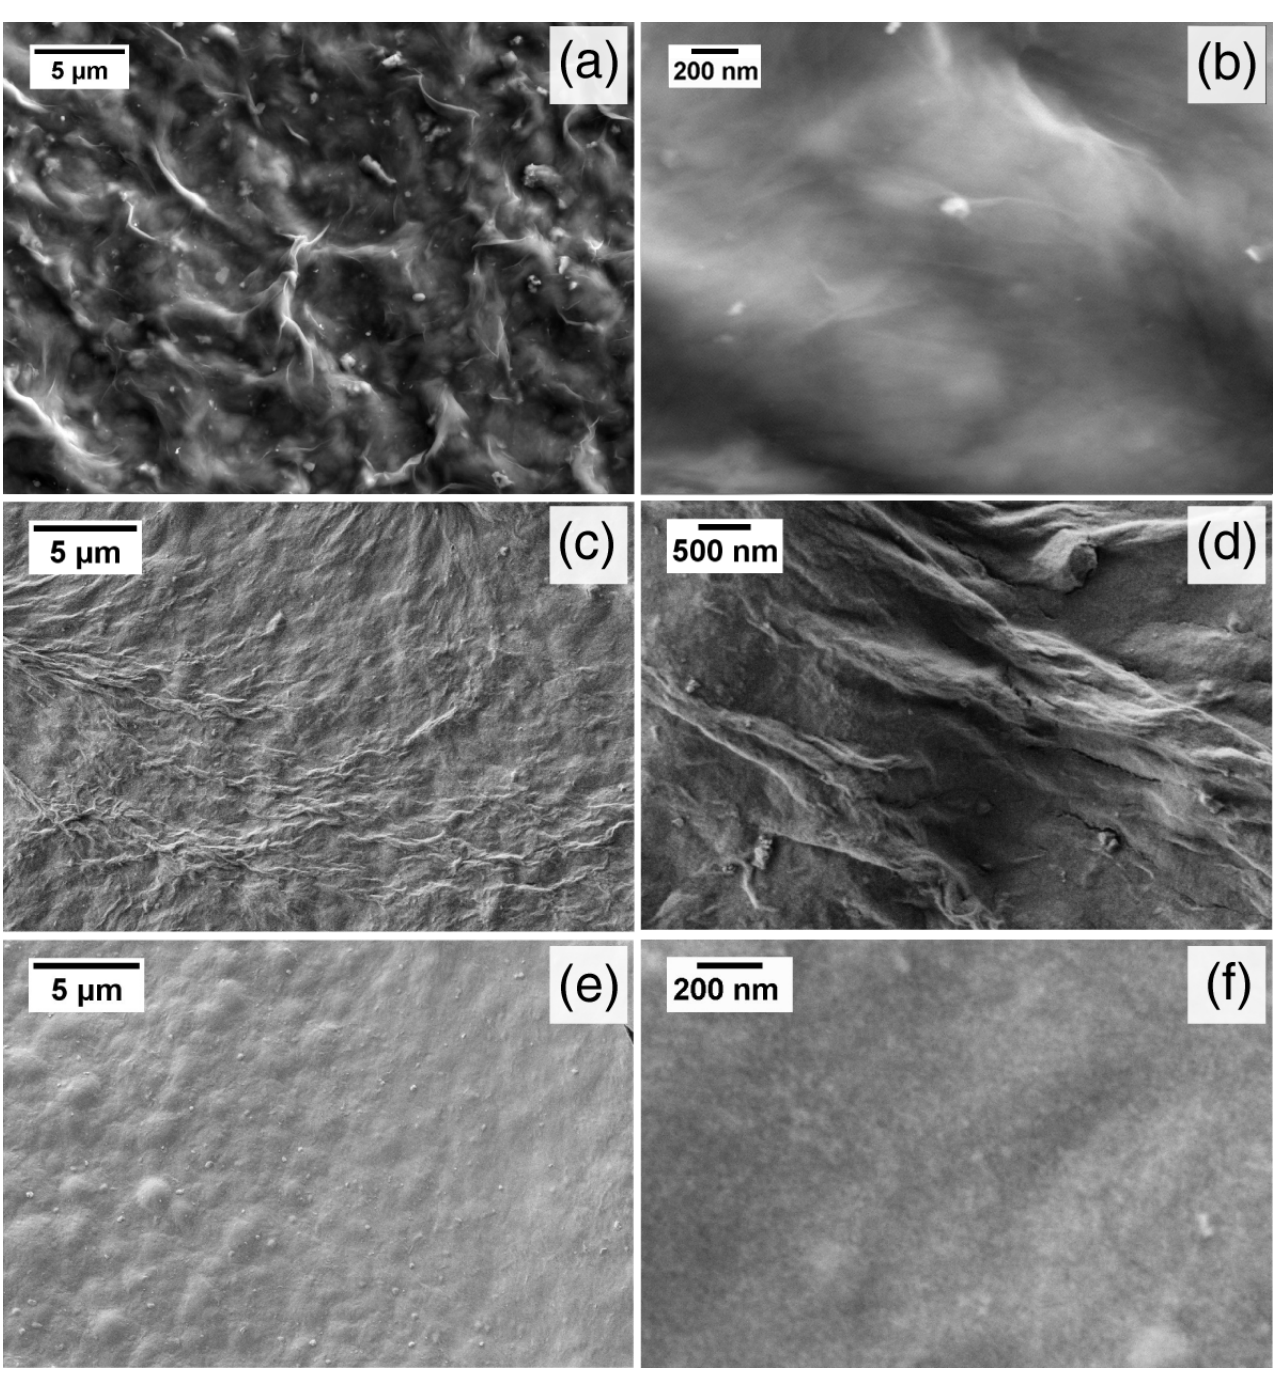
Figure 4. The SEM micrographs of films on a special Al 2 O 3 /Pt substrate: initial MXene ( a , b ), oxidized at 316 °C ( c , d ) and 447 °C ( e , f ).